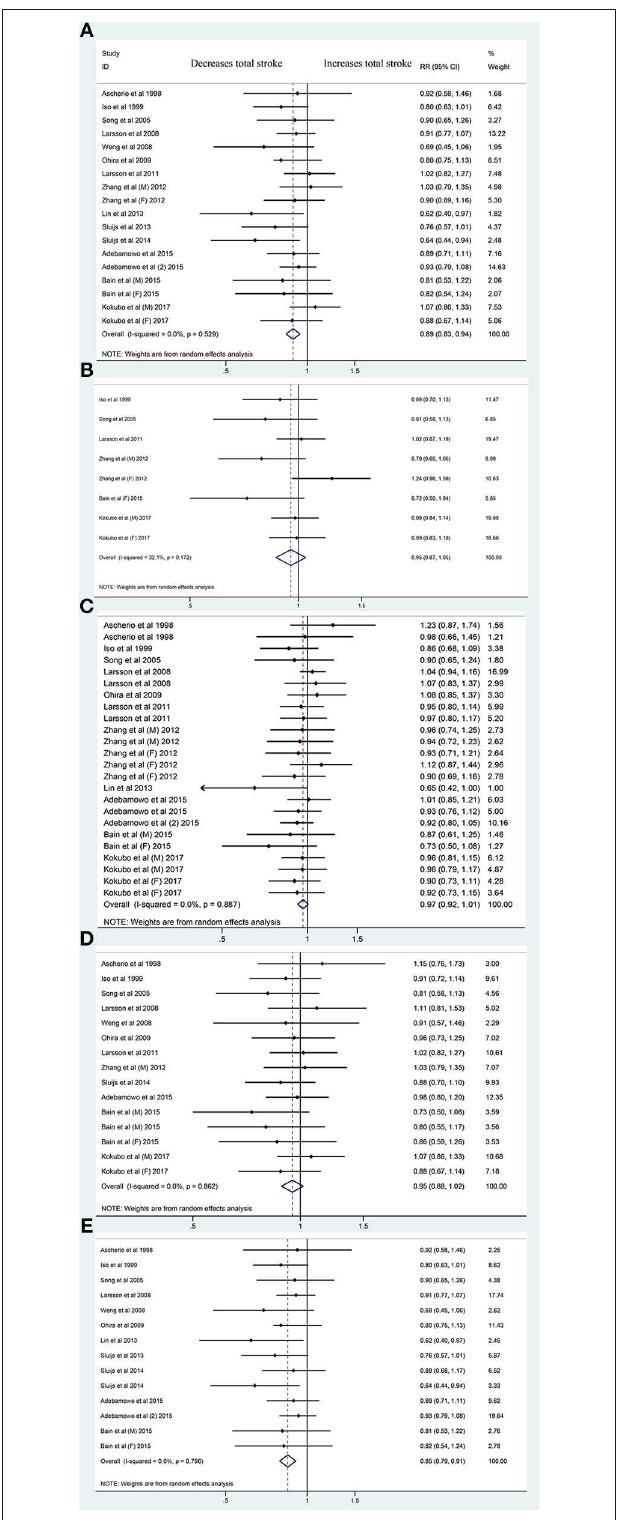
FIGURE 1 | Forest plots of the risk of total stroke for magnesium intake (A) and for < 50 mg/day (B) , ≥ 50 and < 100 mg/day (C) , ≥ 100 and < 150 mg/day (D) , and ≥ 150 mg/day Magnesium Increments (E) . A total of 15 publications